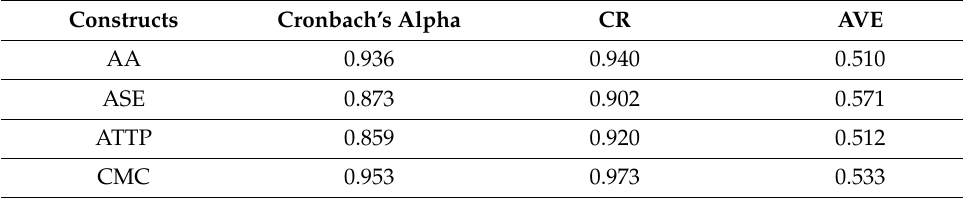
Table 5. Cronbach’s Alpha, CR, and AVE scores of the scales.